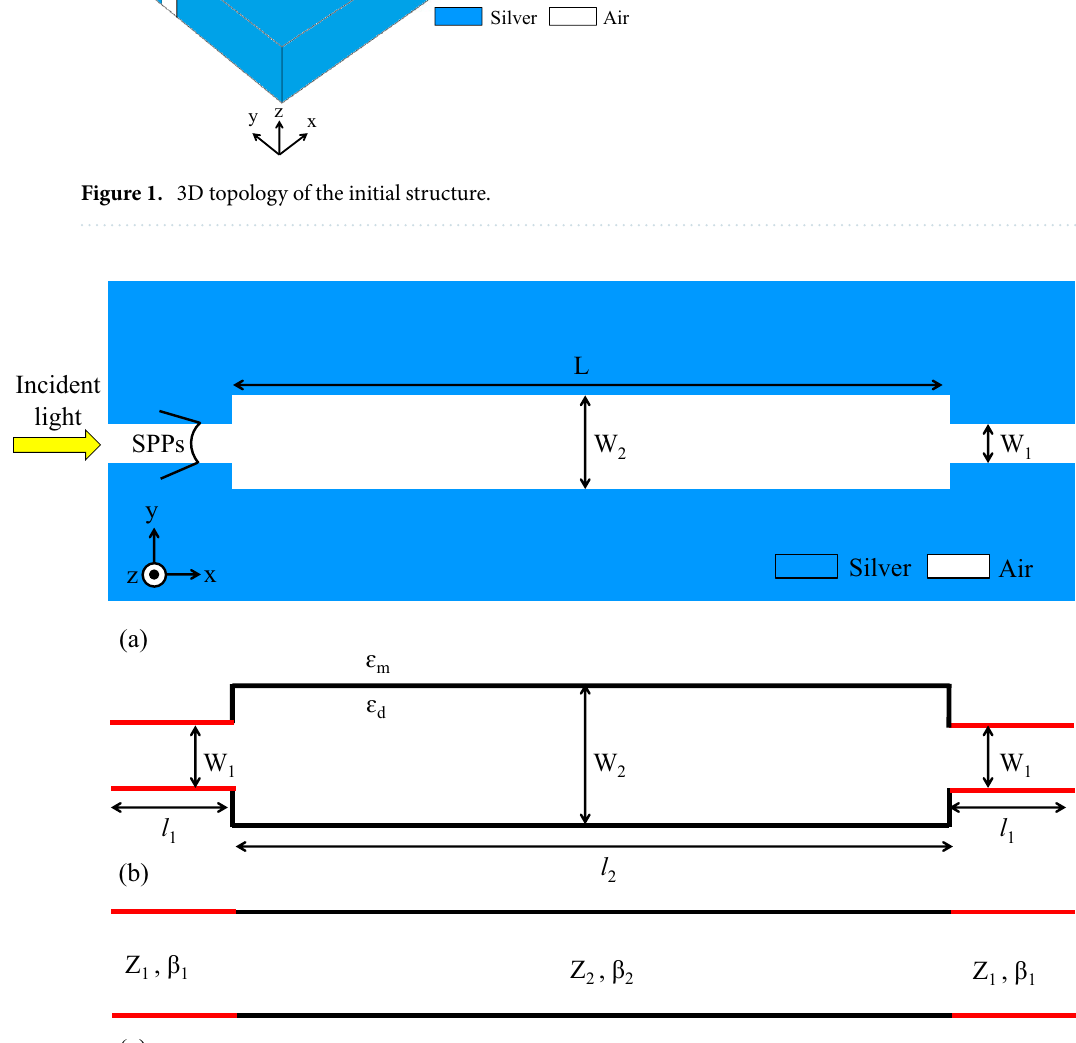
Figure 2. ( a ) 2D topology of the initial structure. ( b ) Schematic of MIM junctions between three waveguides, ( c ) Equivalent transmission line circuit of the initial